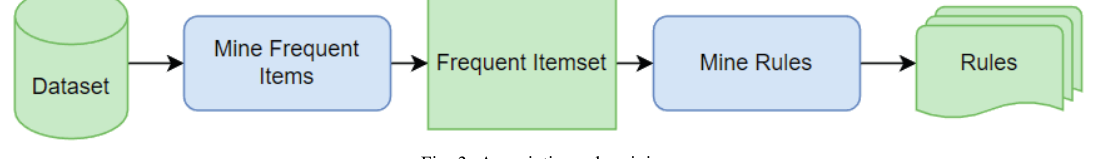
Fig. 3. Association rule